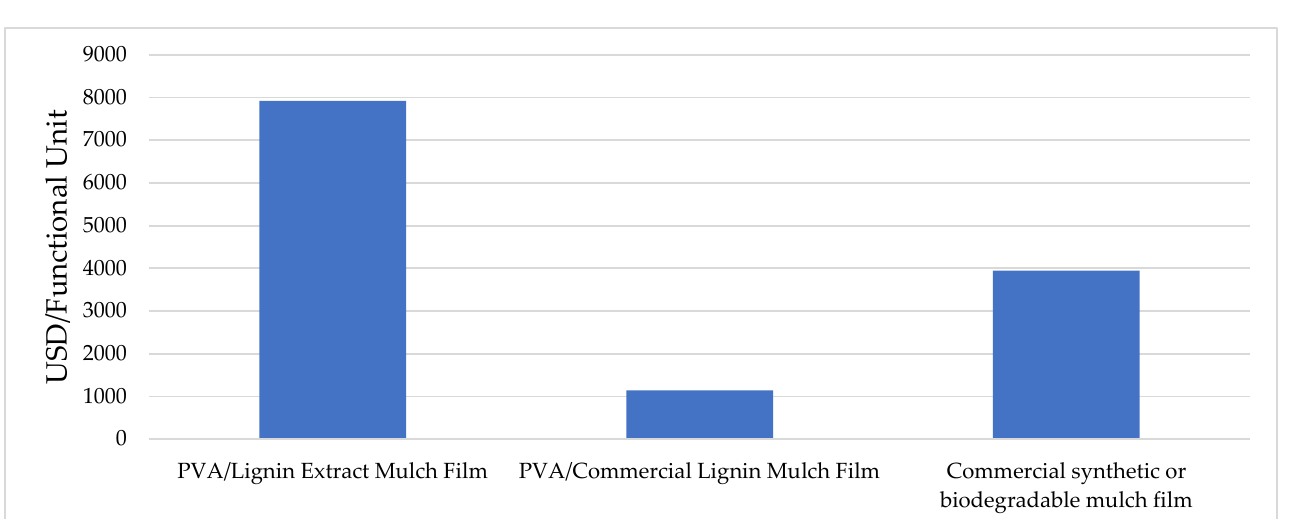
Figure 15. Total cost estimate per functional unit of 1 t of mulch film The cost of PVA – commercial lignin mulch film (USD1147.889) was lower than the commercial synthetic or biodegradable mulch film (same prices for both, USD3950).